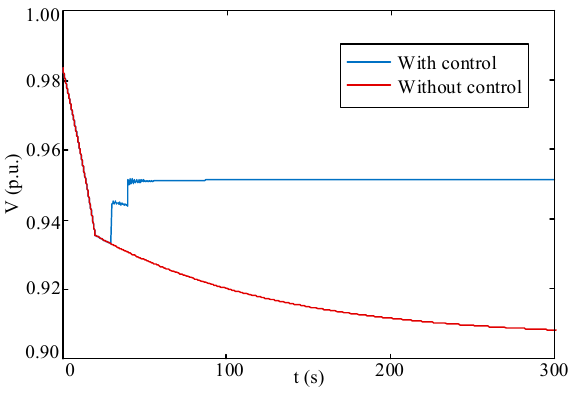
Figure 17. Voltage evolution of bus 83 in IEEE 118 test system using AH-MPC.